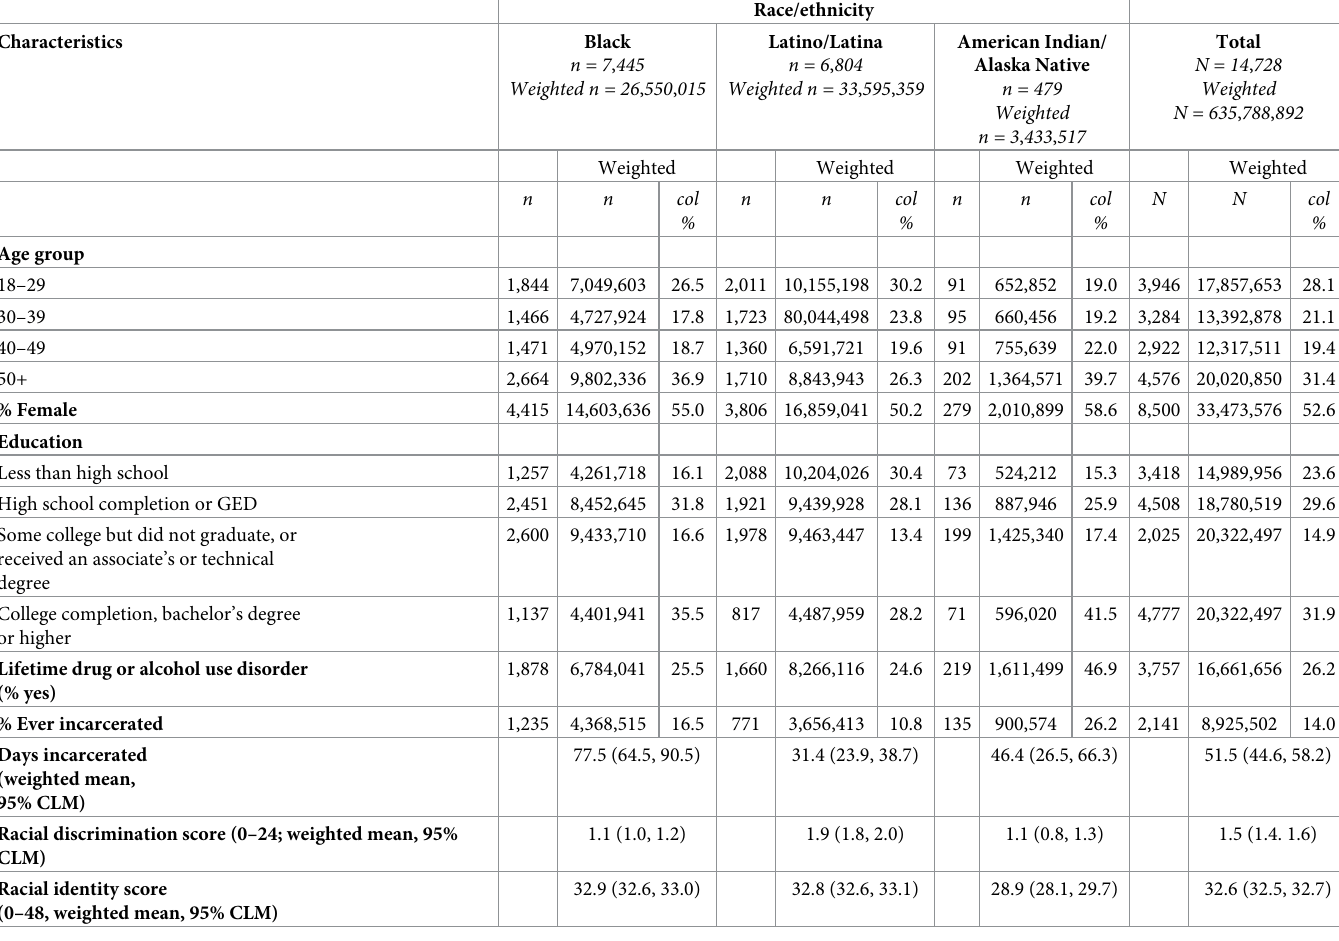
Table 1. Descriptive characteristics of the National Epidemiologic Survey of Alcohol and Related Conditions-III participants (2012–2013, N = 14,728, weighted N = 635,788,892).